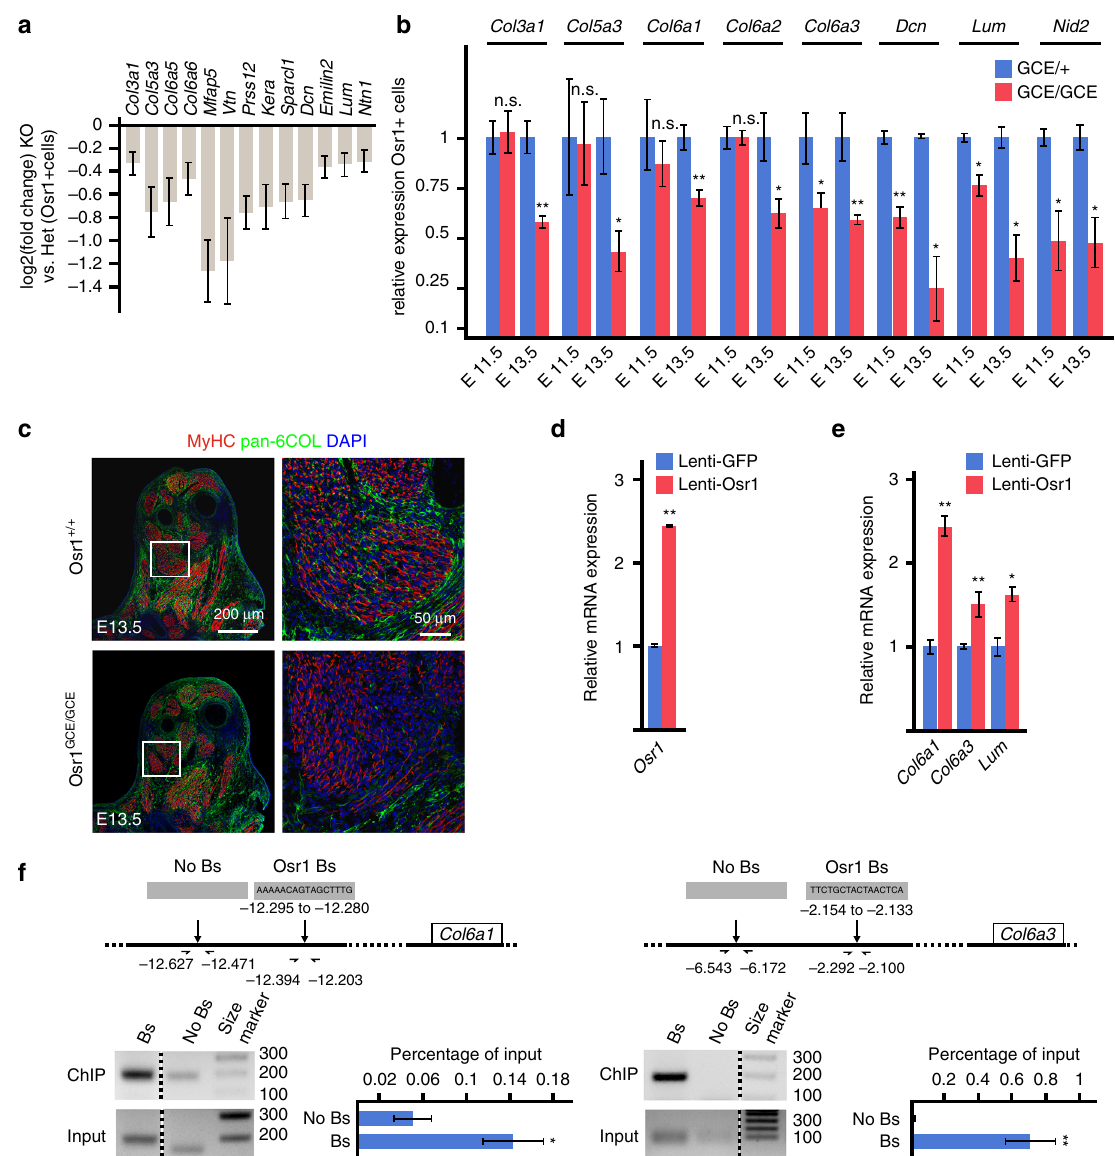
Fig. 7 Osr1 is required for muscle connective tissue ECM gene expression. a Bar graph plot of genes selected from all DE genes by their expression associated with muscle connective tissue; most of the genes belong to the downregulated cluster in (Fig. 6c). b Con fi rmation of downregulation of selected MCT-ECM genes in E11.5 and E13.5 Osr1 de fi cient cells by RT-qPCR ( n = 4). c Immunolabelling for MyHC and COL6 shows reduced abundance of COL6 in Osr1 mutants. d Transduction of E13.5 MEFs with lentiviral particles causes mild overexpression of Osr1 . e Lentiviral overexpression of Osr1 causes upregulation of Col6a1 , Col6a3 and Lum genes. f Chromatin immunoprecipitation of putative Osr1 binding sites at the Col6a1 and Col6a3 loci. Above: schematic representation of the loci; positions of Osr1 binding sites and PCR primers relative to exon 1 of the Col6a1 and Col6a3 genes are indicated. Below: representative gel pictures of ChIP vs. input are shown left, con fi rmation of binding site pulldown via RT-qPCR ( n = 3) are shown right. Bs: putative binding site, No Bs: control region. Size marker: 100 base pair ladder; band sizes are indicated in base pairs. Error bars represent log2 fold change standard error (ifcSE) estimated by DESeq2 in a and s.e.m. in ( b , d , e , f ). T-test: * = p < 0.05; ** = p < 0.01; *** = p < 0.001. N-numbers indicate biological replicates, i.e. samples from different specimen in b or independent assays in d , e ,